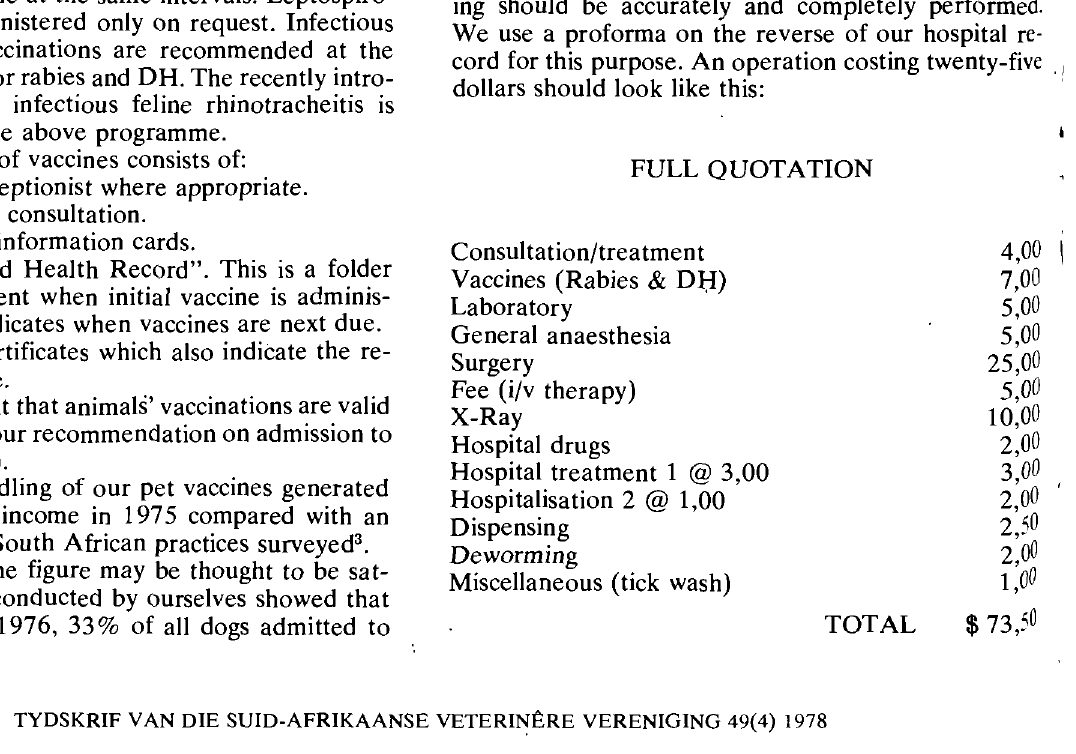
Fig. 10. Vaccination